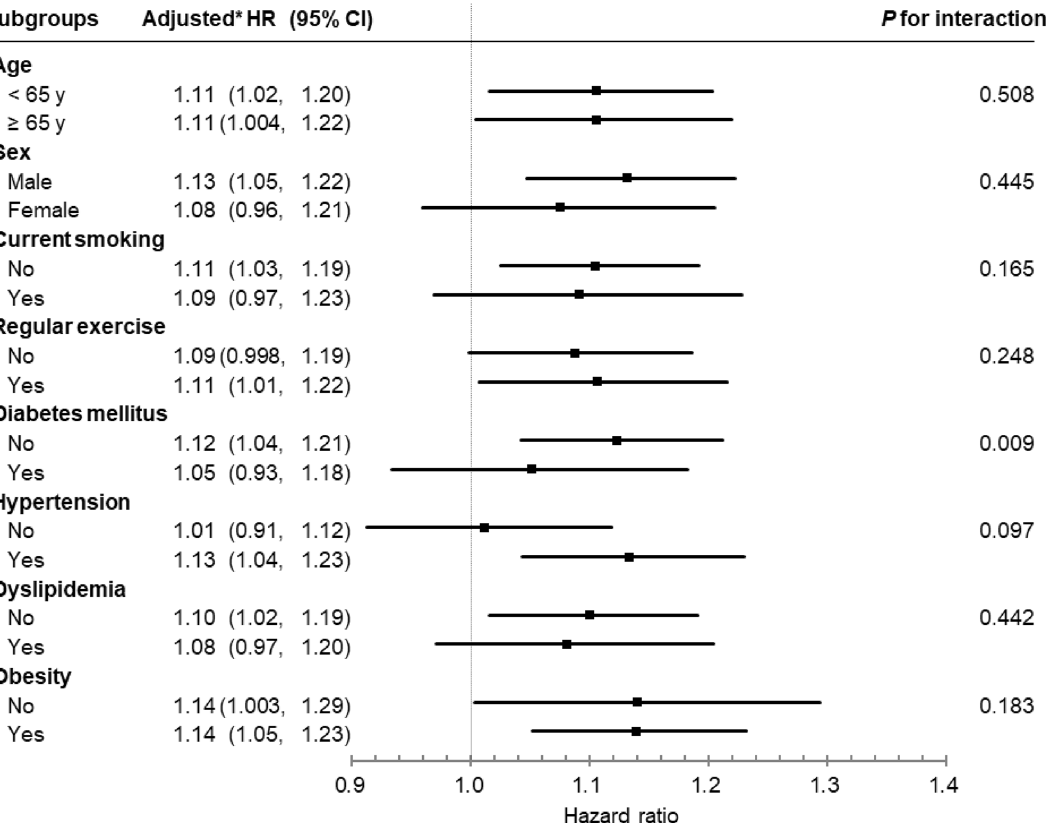
Figure 2. Association between non-alcoholic fatty liver disease and the risk of pancreatic cancer by subgroup. Forrest plots of hazard ratios (HRs) and 95% confidential intervals (CIs) adjusted for age, sex, smoking, alcohol consumption, physical activity, income level, body mass index, diabetes, and pancreatitis according to subgroups.